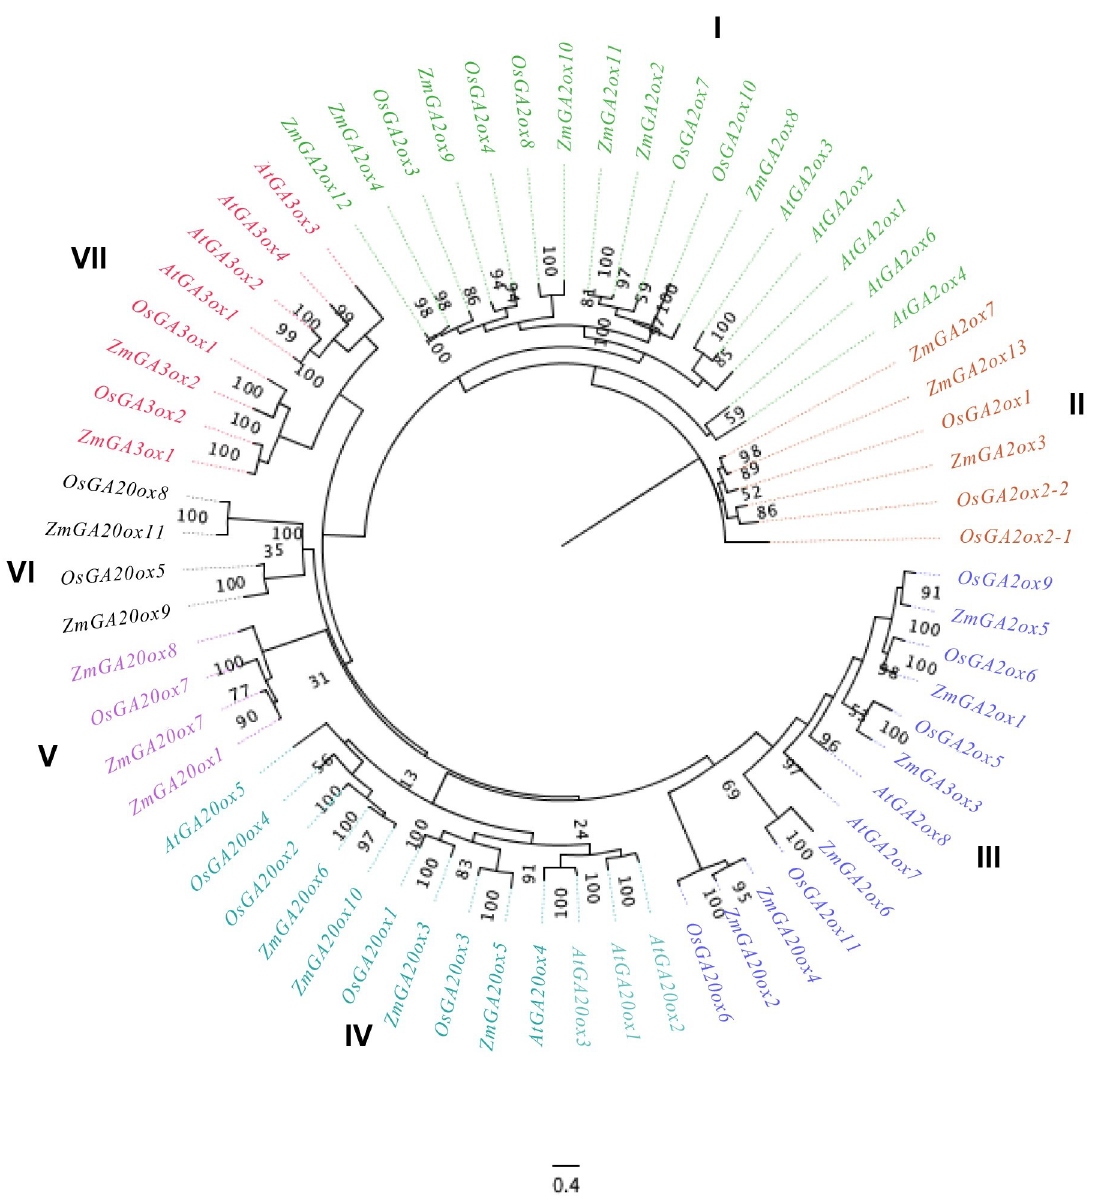
Fig 3. Phylogenetic analysis of gibberellin-dioxygenases proteins among maize (27), Arabidopsis (16) and rice (22). The phylogenetic tree was constructed based on the full-length protein sequences using Figtree software. Seven subgroups (I-VII) are shown in various